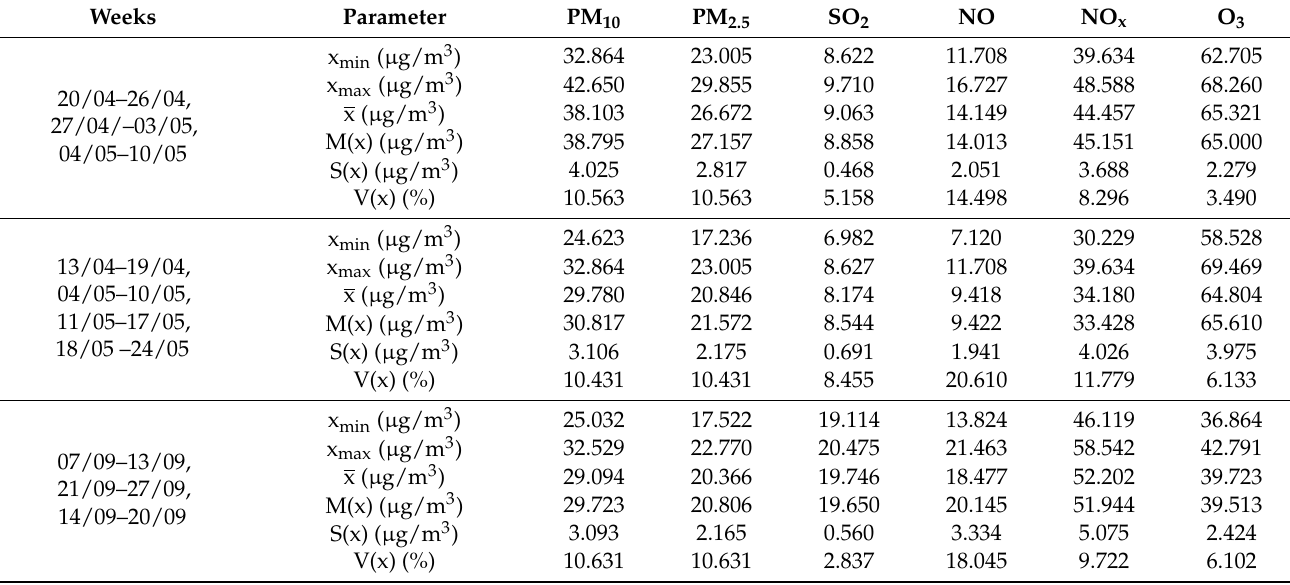
Table 9. A summary of the basic average measures and measures of relative variability for the “summer